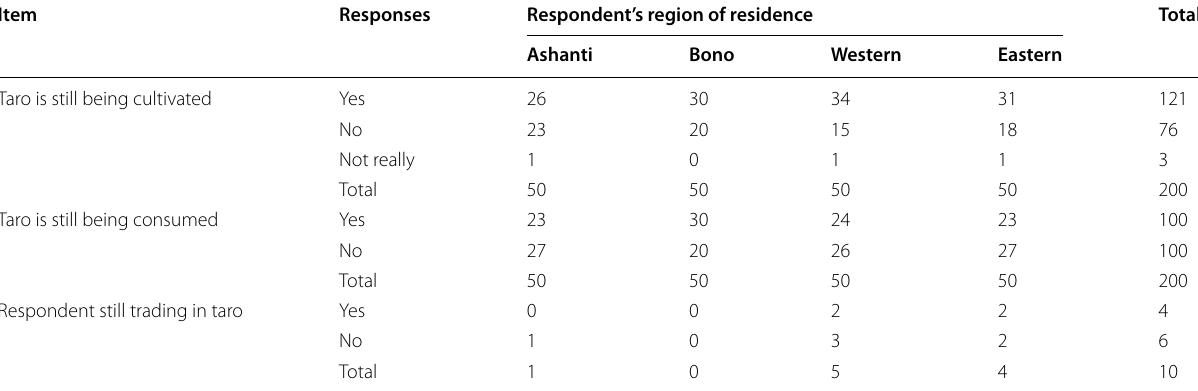
Table 4 Current information on cultivation and utilization of taro in the study areas Item